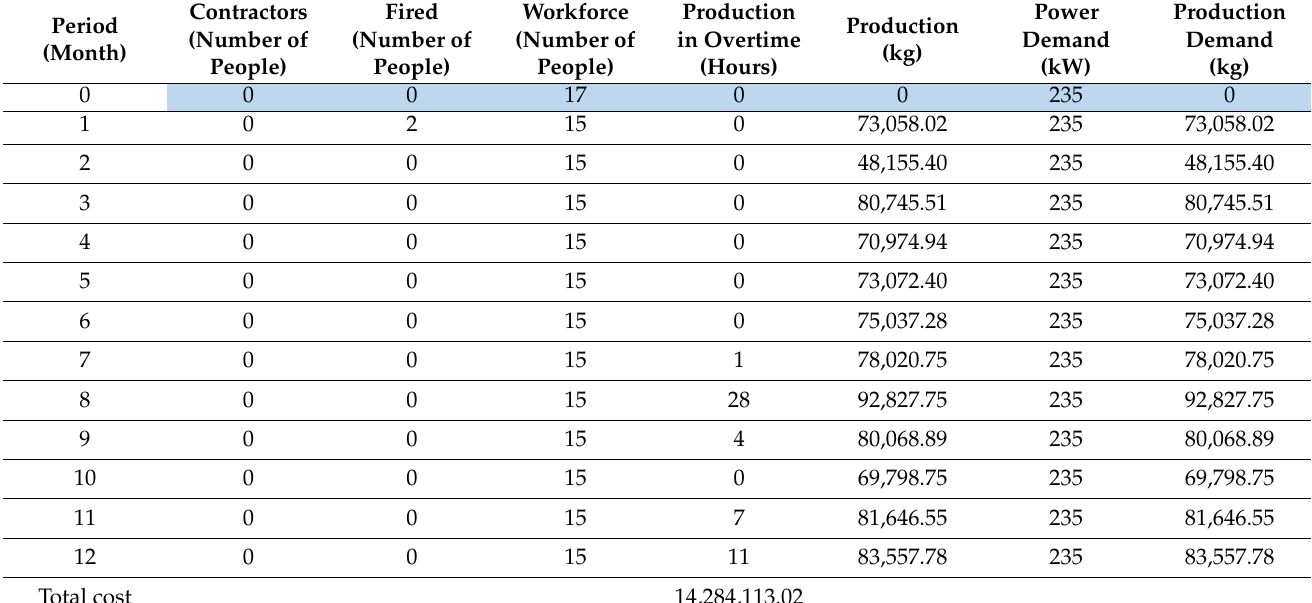
Table 6. Aggregate plan as a proposed scenario considering power